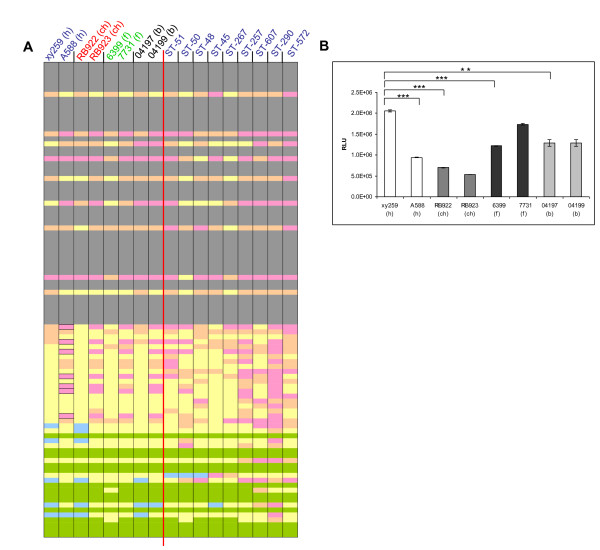
Differences between ST-21 C. jejuni strains in metabolic activity and energy levels. (A) Carbon source utilization by eight ST-21 strains (left panel) from different sources (h = human; ch = chicken; b = bovine; f = food) and nine human-derived strains (from left to right: xy898, R267, xy904, A396, 222, 02551, 02557, A412 and A599) of different STs (right panel) were tested at 42°C using BioLog Phenotype Microarray PM1 plates (area values). Grey color indicates no or only weak substrate utilization for all strains (all area values below 800) and green indicates high substrate utilization for all strains (all area values above 800). The colors pink, yellow, beige and blue indicate strain-specific utilization: pink-zero utilization, beige-< 1,000, yellow-< 9,000, blue-> 9,000. The six bordered rectangles on the left panel (from top to bottom, second from left column) indicate the substrates L-galactonic acid-g-lactone, tyramine, m-hydroxy-phenylacetic acid, p-hydroxy-phenylacetic acid, glycyl-L-aspartic acid, glycyl-L-glutamic acid and glycyl-L-proline, which are not used by some strains (phenotypic variant 1). PM1 experiments with ST-21 strains were performed at least three times independently on different days. Shown for each substrate are the mean area values of three independent experiments performed at 42°C for 30 h incubation time. PM1 experiments for other STs were performed either once or twice (mean values shown for ST-45 and ST-267 strains) at 42°C. (B) Differences in intracellular ATP levels (energy harvest) of eight ST-21 strains from different sources. Statistics was performed using a Student's t test. A p-value of < 0.05 was considered statistically significant (* p ≤ 0.05, ** p ≤ 0.01, *** p ≤ 0.001).